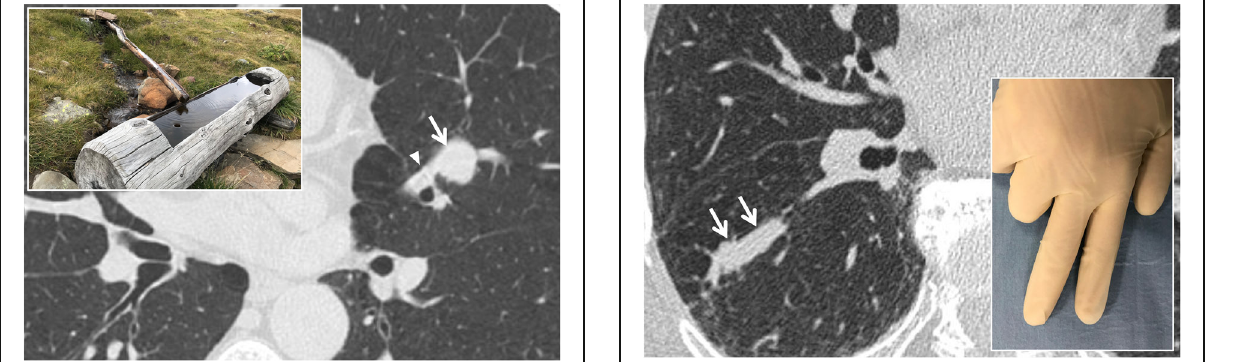
Fig. 11 Feeding vessel sign. A patient with a pulmonary arterial- venous malformation (white arrow) — located in the upper left lobe; the respective feeding vessel (white arrowhead) is clearly depicted. More in detail, the “ feeding vessel sign ” could be described in cases of a pulmonary vascular branch that runs towards a focal lesion —“ getting lost ” in its context: it resembles the channel of water which provides adequate filling (as reproduced in the embedded figure)